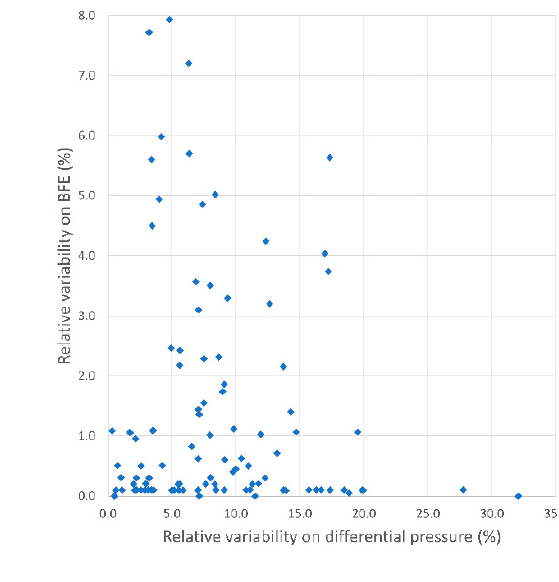
Table 2. Number of tested masks broken down according to mask material and number of layers.